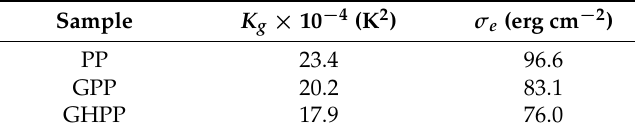
Table 3. The kinetic parameter for crystal growth ( K g ) and interfacial free energies of crystal growth ( σ e ) under self-nucleation isothermal crystallization